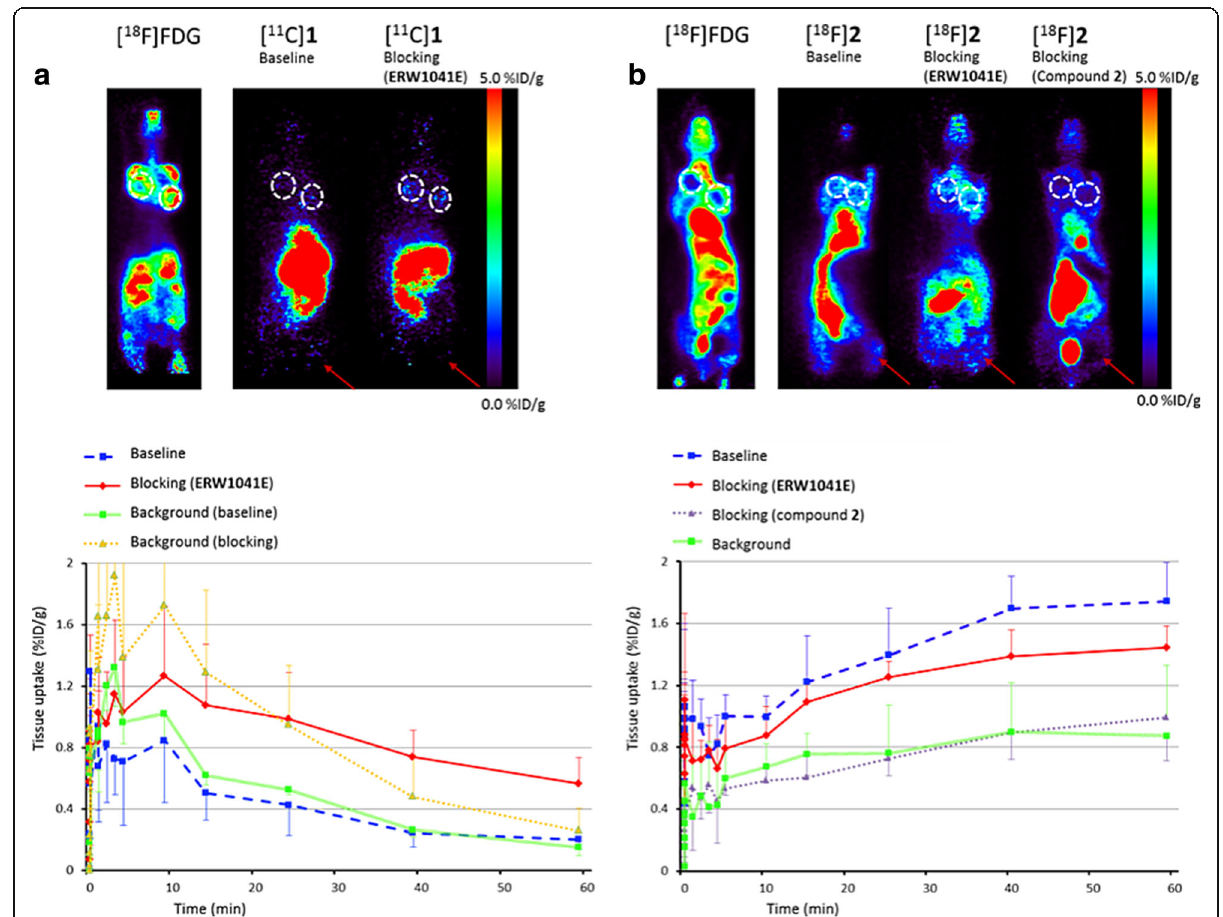
Fig. 4 PET images and TACs of [ 11 C] 1 or [ 18 F] 2 in MDA-MB-231 tumour bearing SCID mice ( n = 4 per group). Tumours are indicated with white dotted ellipses, background tissue (muscle) is indicated with a red arrow. a Representative PET images of [ 18 F]FDG scan and the last time-frame (40 – 60 min) after administration of [ 11 C] 1 under baseline and blocking conditions, and TACs of tumour under baseline (blue line) and blocking (red line) conditions and of background tissue under baseline (green line) and blocking (yellow line) conditions. b Representative PET images of [ 18 F]FDG scan and the last time-frame (40 – 60 min) under baseline conditions, and after blocking ( ERW1041E ) and self-blocking with 2 after administration of [ 18 F] 2 , together with TACs of tumour under baseline (blue line) and blocking conditions (red and purple line), and of background tissue under baseline (green line)